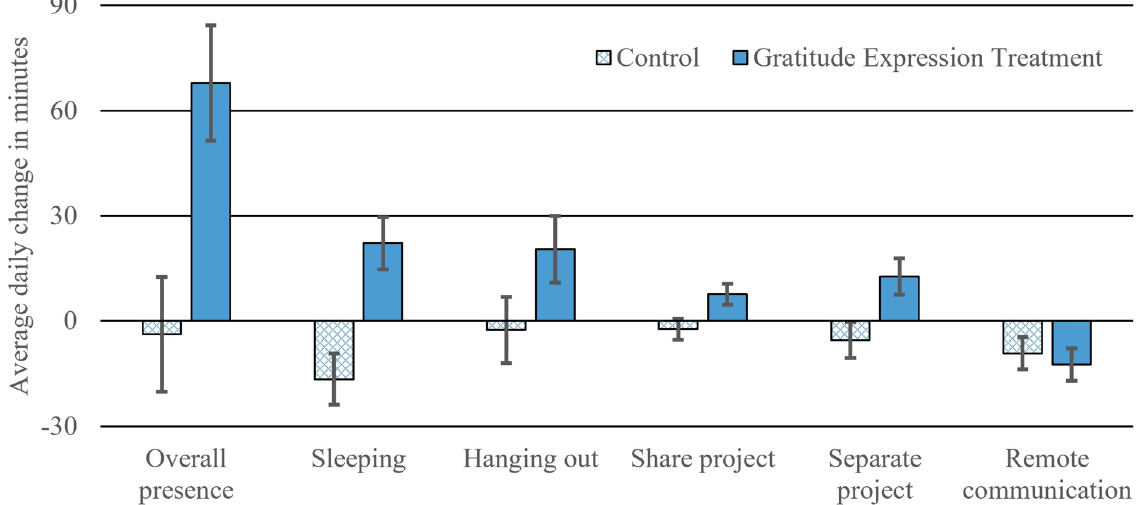
Figure 3. Change in time spent from the baseline to the experimental phase of the study (and the SE of the change), depending on experimental condition, for each way the couple may have been physically co-present.